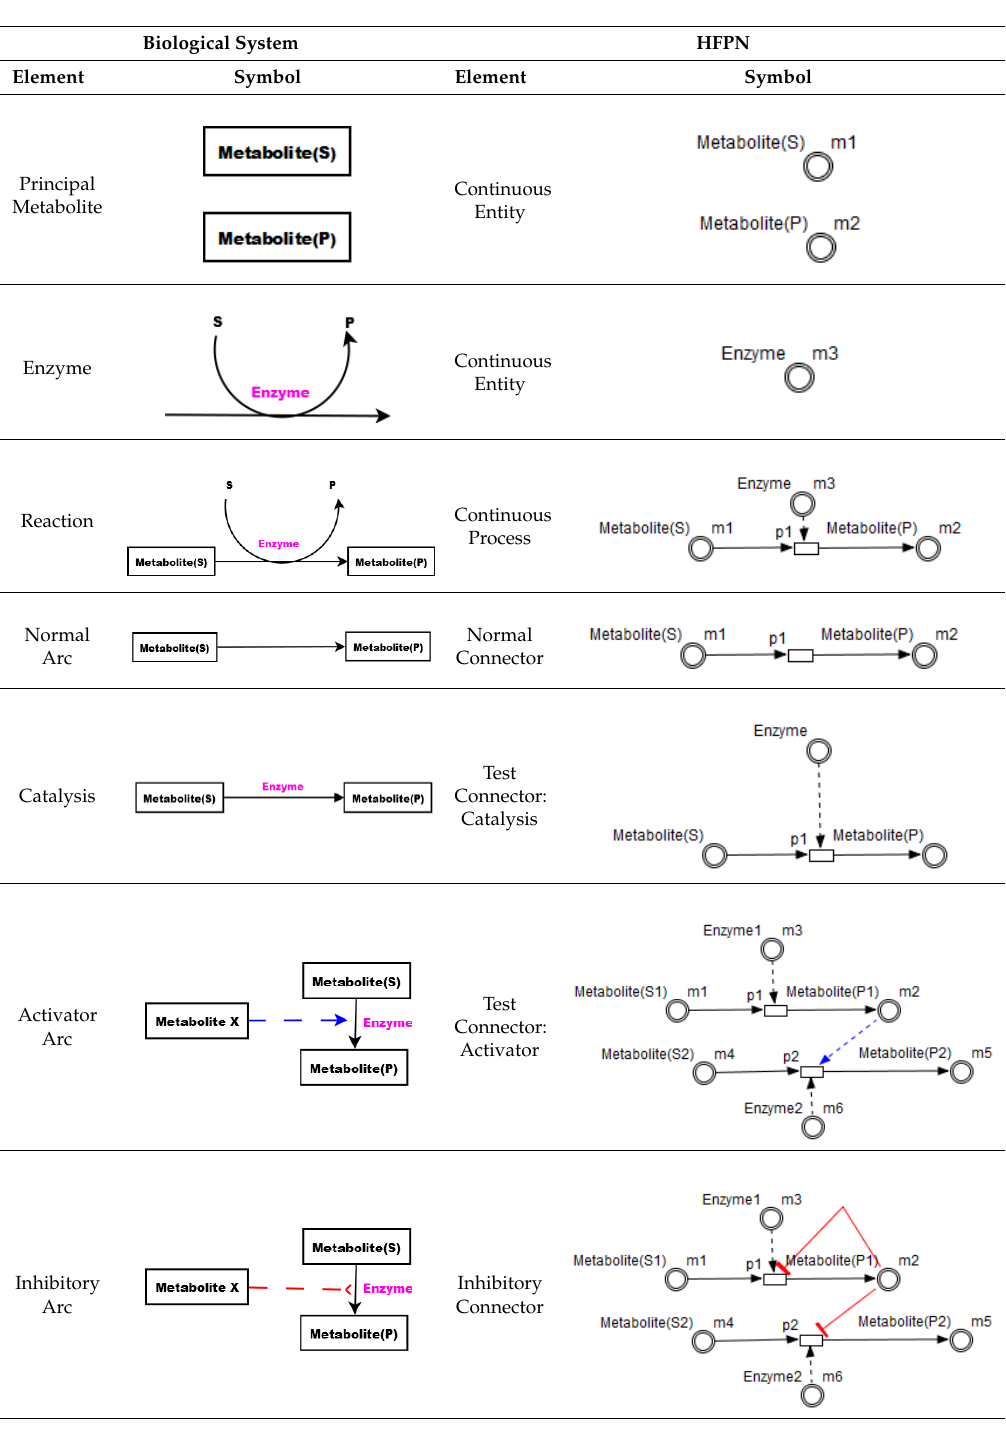
Table 1. Biological System to HFPN General